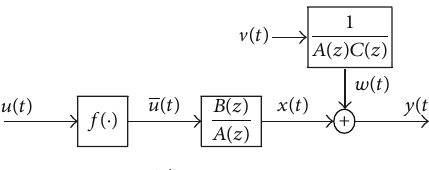
Figure 1: The IN-CARAR